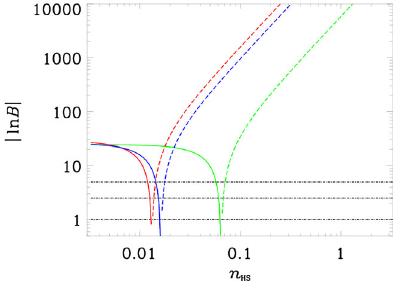
Fig. 31 The Bayes factor ln B for the f ( R ) model of Eq. (I.5.36) over standard Λ CDM as a function of the extra parameter n . The green, red and blue curves refer to the conservative, bin-dependent and optimistic (cid:23) max ,